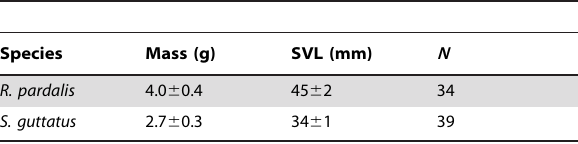
Table 1. Masses and lengths of the two species used in the